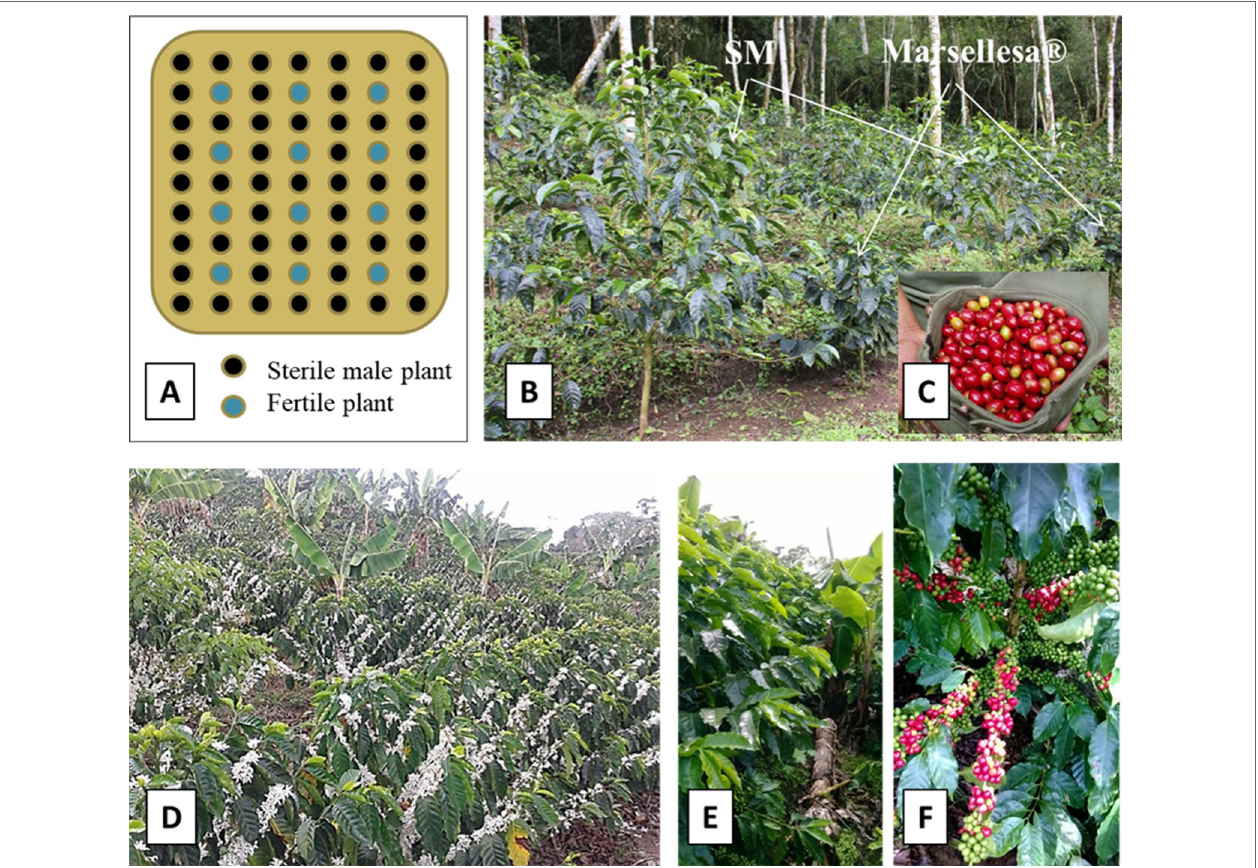
FIGURE 2 | Experimental seed garden used to produce seeds of Starmaya F1 hybrid of C. arabica . (A) Scheme of planting in seed garden to produce seeds of Starmaya F1 hybrid. The fertile plants (in blue) producing pollen correspond to Marsellesa ® pure line variety. The sterile male plants corresponding to CIR-SM01 produce Starmaya seeds. In seed garden, the ratio is approximately one plant of Marsellesa for 4 plants of sterile male (SM) CIR-SM01. (B) Seed garden established in the field of “La Cumplida” farm located in Matagalpa (Nicaragua). (C) First seeds of Starmaya F1 hybrid harvested in seed garden in 2011. (D) First flowering (in 2014) of Starmaya F1 hybrid plots established at “La Cumplida” farm. (E) Starmaya plants in 2015. (F) Aspect of producing branches of Starmaya producing the first commercial yield in 2015.